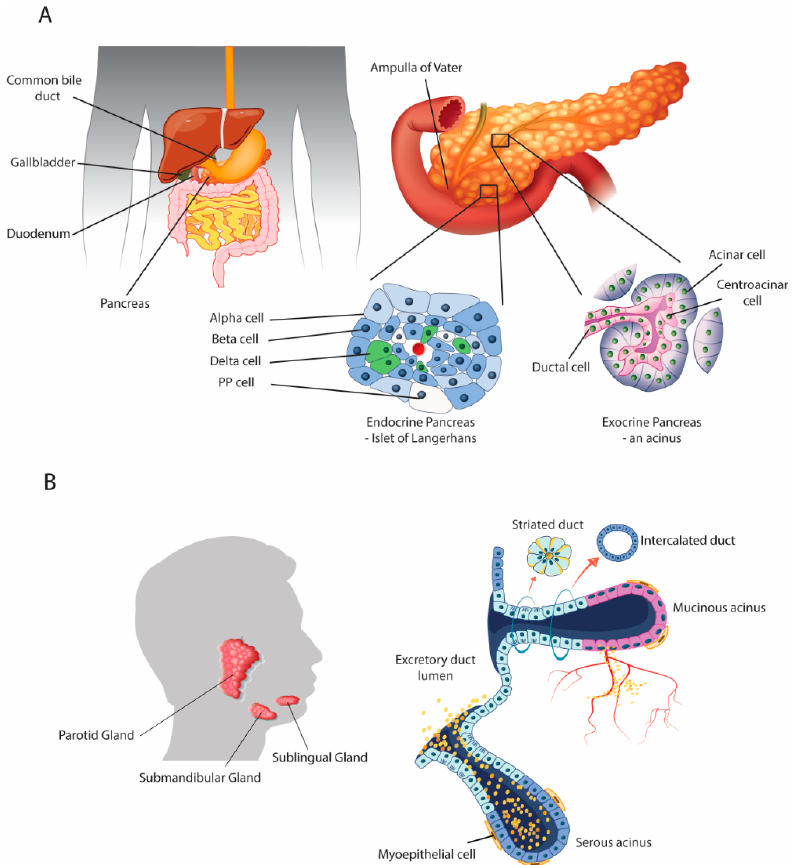
Figure 1. Anatomical structures of the pancreas and salivary glands. Both the pancreas and salivary glands are composed of exocrine acinar structures, and both have endocrine functions by secreting chemical messengers into the bloodstream to exert effects on distant organs. ( A ) The pancreas is a retroperitoneal organ connected to the liver proximally by the common bile duct and distally to the duodenum via the pancreatic duct. Exocrine pancreas acinar cells secrete pancreatic juice into the acinar ducts, which is eventually released into the duodenum via the ampulla of Vater to digest chyme. The endocrine pancreas is formed from islets of Langerhans distributed throughout the pancreas, which are formed predominantly of α - and β -cells, which are glucagon and insulin secreting, respectively, but also minor cell types including delta cells (somatostatin) and pancreatic polypeptide (PP) cells. ( B ) Similarly, the salivary glands (parotid, submandibular, and sublingual) are formed of acini, which secrete saliva from mucous or serous units via ducts. Saliva contains a complex bioactive mixture including digestive enzymes. Although not traditionally thought of as an endocrine organ, the salivary gland also secretes bioactive molecules (e.g., epidermal growth factor (EGF), hepatocyte growth factor (HGF) and transforming growth factor alpha (TGF- α )), into the bloodstream to a ff ect distant